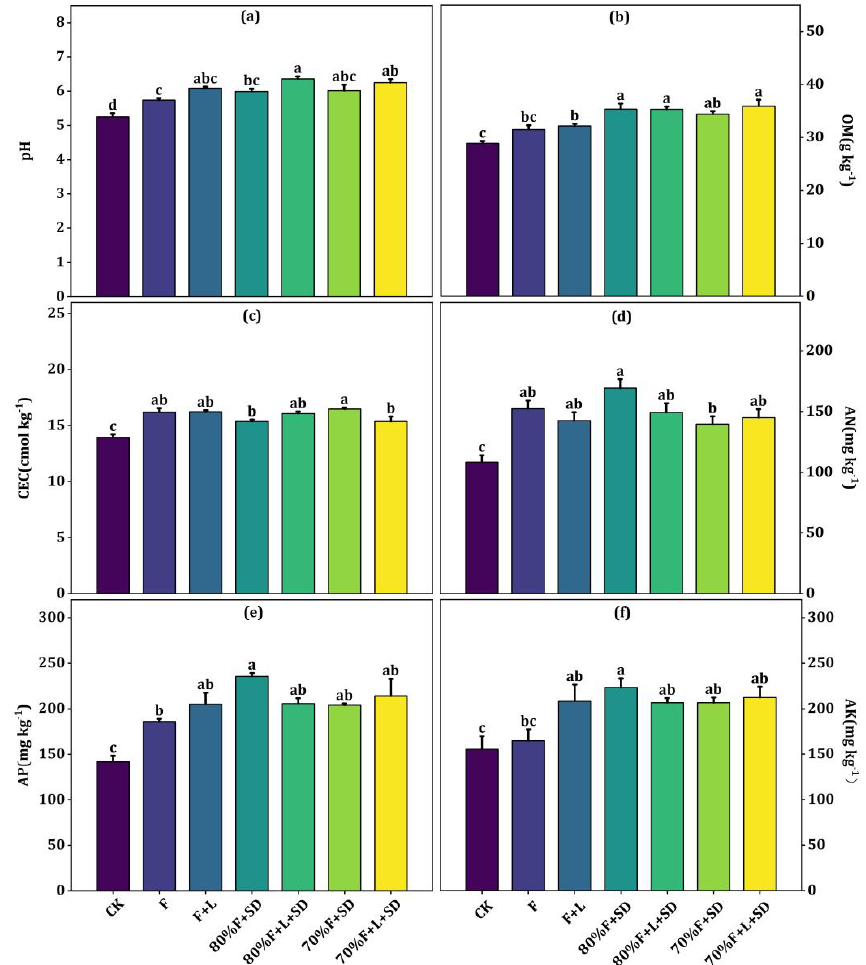
Figure 2. Effect of LSF on soil pH ( a ), OM ( b ), CEC ( c ), AN ( d ), AP ( e ), and AK ( f ) of A. selengensis . All values are means of three replicates with error bars indicating the standard error. Different lowercase letters show significant variability among treatments ( p < 0.05).